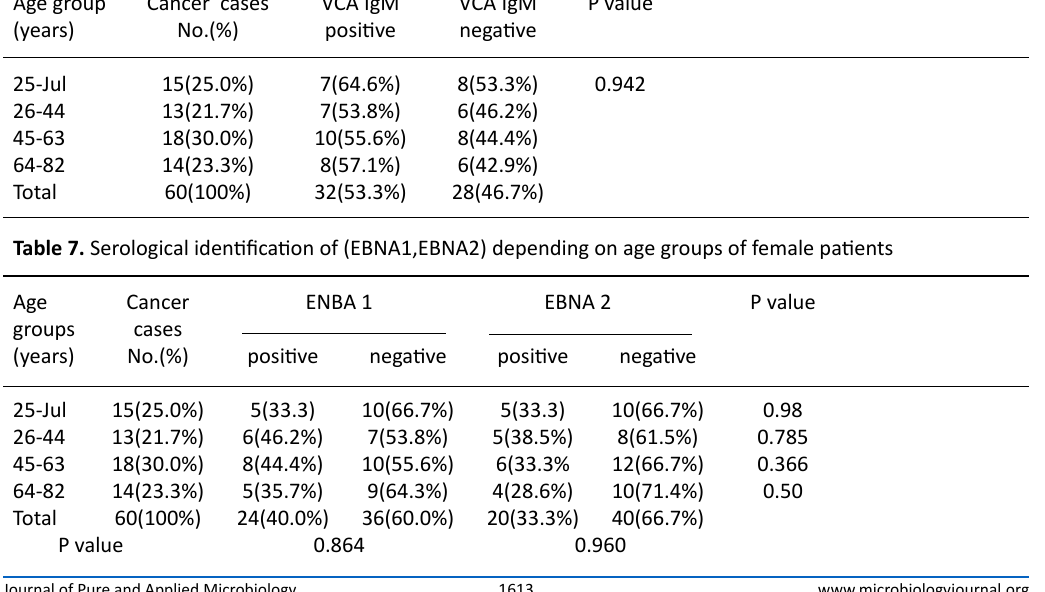
Table 6. Serological identification of (VCA IgM) by age groups of male cases Age group Cancer cases VCA IgM VCA IgM P value (years)